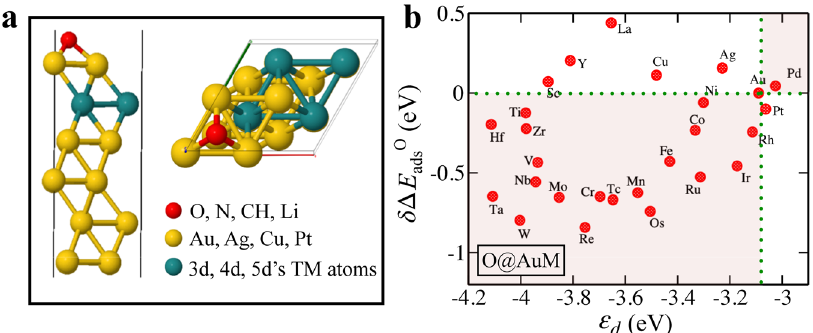
Fig. 5 Chemisorption on NSAs as function of d -band center. a Top and side view of adsorption on NSAs. b Variations in the adsorption energy for O on Au NSAs as a function of d -band center ( ε d ). Only the guest atoms in the subsurface layer have been